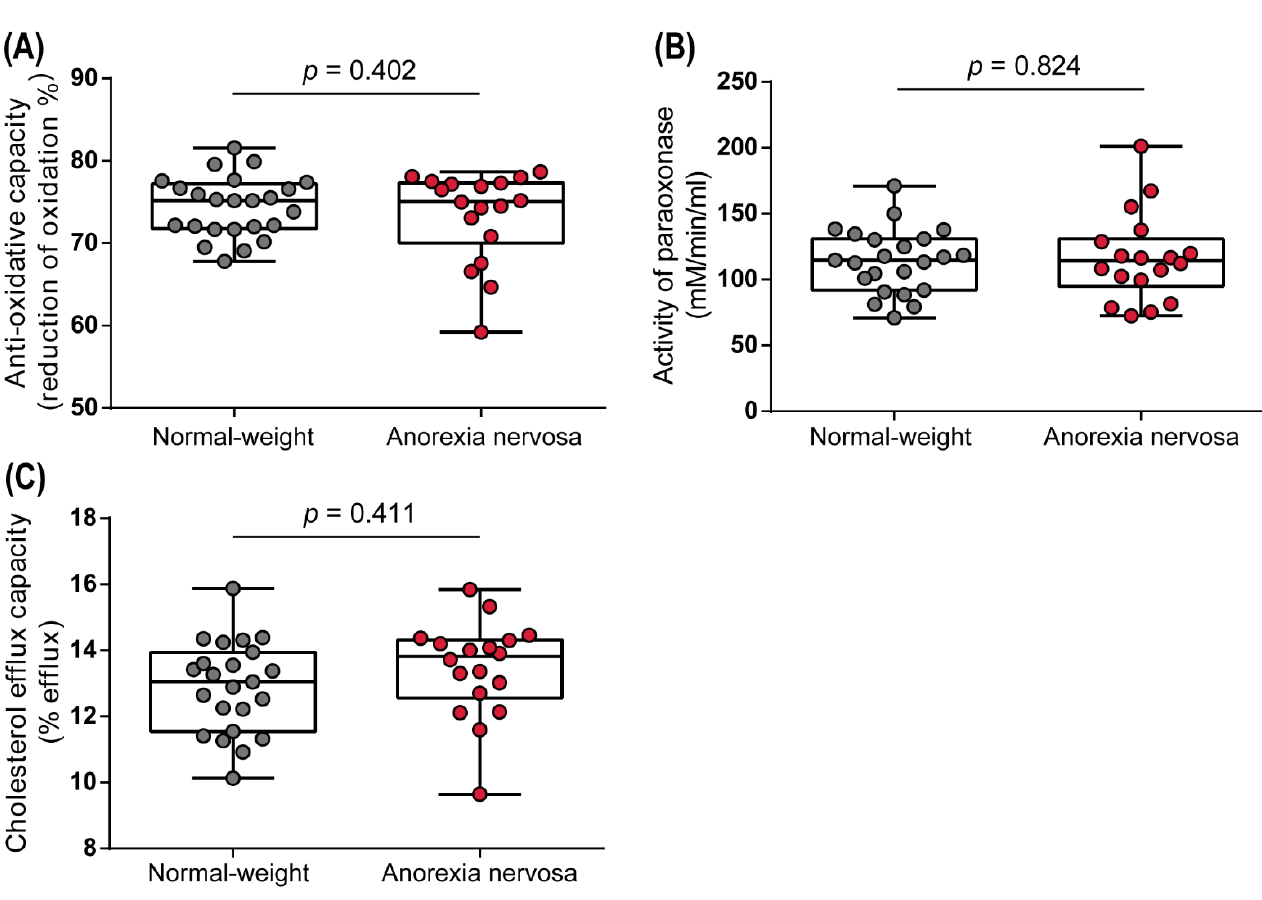
Figure 3. Parameters of HDL function in normal-weight and anorexia nervosa women. The anti- oxidative capacity ( A ) as well as arylesterase activity of PON1 ( B ) were assessed in apoB-depleted serum. Cholesterol efflux capacity was determined using a cell-based assay ( C ). Depending on the normal distribution of the data, t-test or Mann–Whitney U test was used to analyze differences be- tween the two groups. Individual data are presented on top of boxplots, displaying median, inter- quartile range, as well as minimum and maximum values. Adjusted p -values according to Benja- mini–Hochberg are displayed.